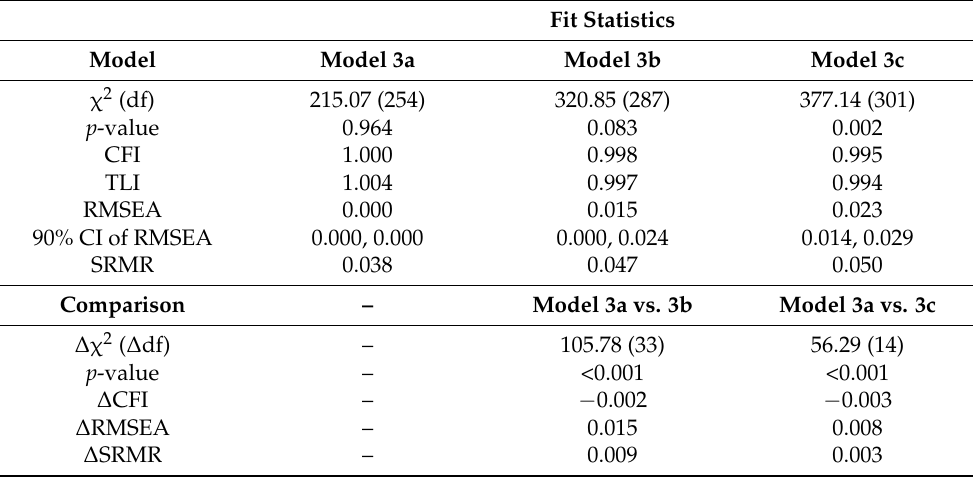
Table 4. Measurement invariance of the bifactor structure for the Sexual Orientation Microaggression Inventory (SOMI) across sex.